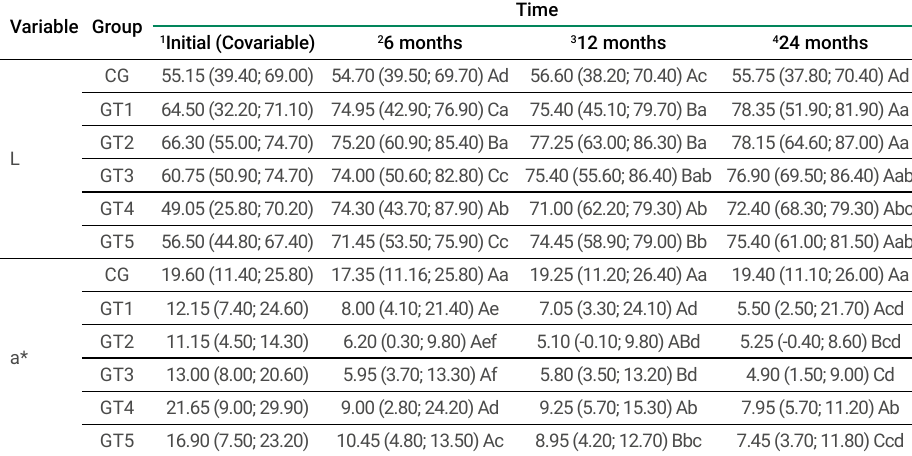
Table 3. Median (minimum; maximum) of the variable relative to color (values L, a and b) in function of group and time. Variable Group